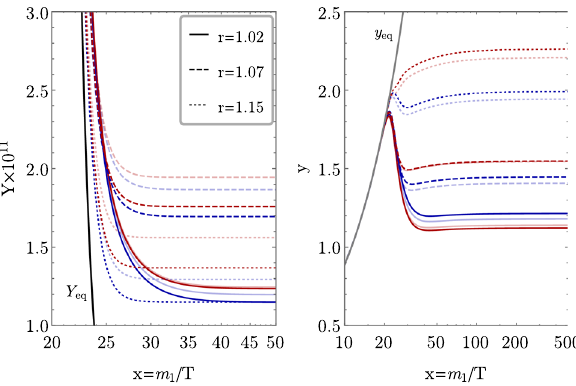
Fig. 8 Evolution of DM abundance Y ( x ) (left) and velocity disper- sion y ( x ) (right) for the sub-threshold model with three selected values of r . DM mass and couplings are fixed as in Fig. 7, and line styles chosen in accordance with that figure. For these threshold examples, DM needs high momenta for annihilation to be kinematically allowed, which results in a phase of cooling around and after kinetic decoupling, and hence a drop in y ( x